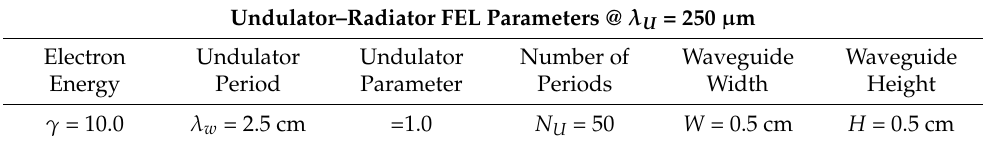
Table 3. Undulator–Radiator FEL Parameters @ λ U = 250 µ